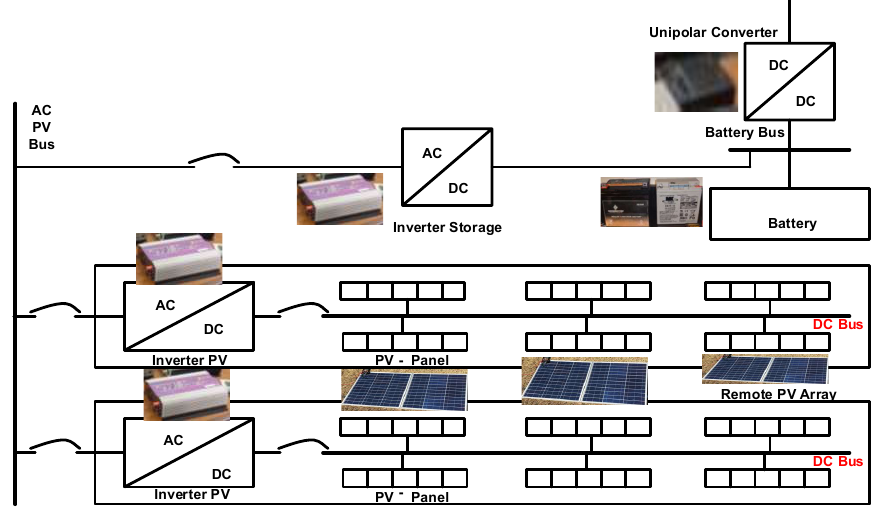
Figure 2. A simple diagram of standalone solar photovoltaic (PV) system with DC microgrid.